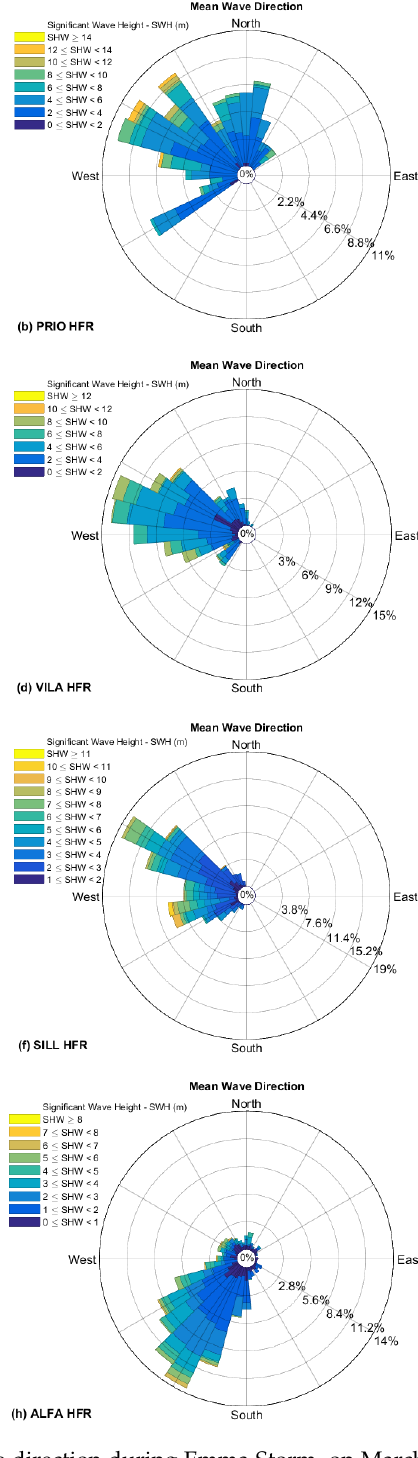
Figure A4. Comparison of the main incoming wave direction during Emma Storm, on March 2018. ( a ) Baves Buoy; ( b ) PRIO HFR; ( c ) Villano-Sisargas buoy; ( d ) VILA HFR; ( e ) Silleiro Buoy; ( f ) SILL HFR; ( g ) Faro coastal buoy and ( h ) ALFA HFR. ( a , c , e , g ) Buoys and ( b , d , f , h )